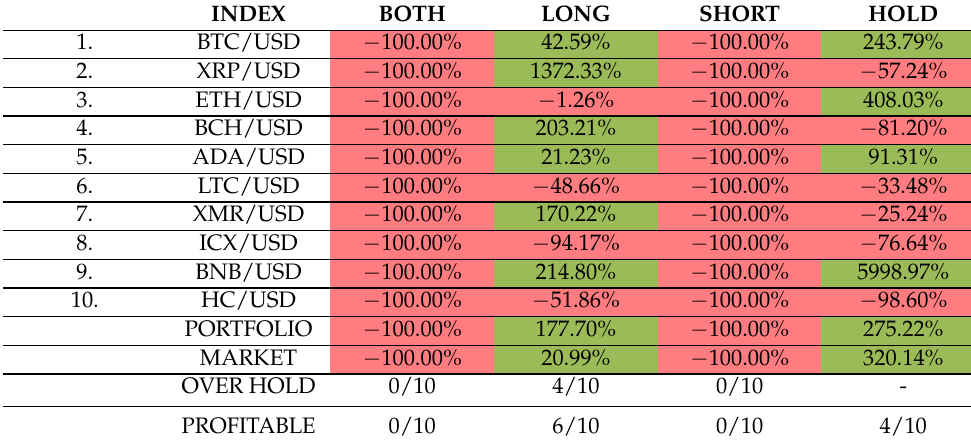
Table 3. The results of the strategy from the first experiment for portfolio and examined cryptocur- rencies. Green indicates positive returns, and red indicates negative